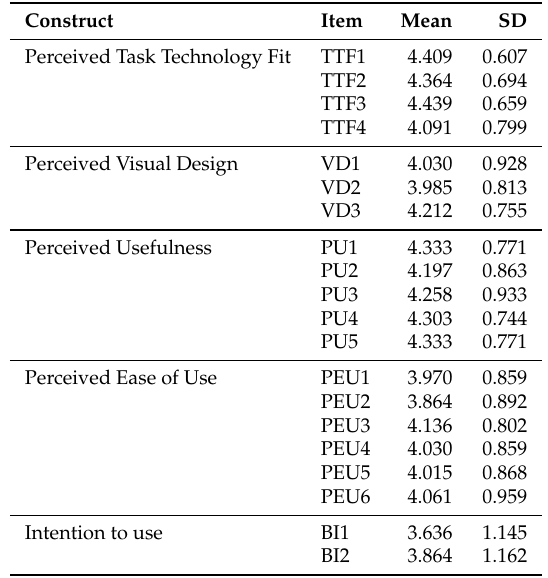
Table 3. Means and standard deviations of TAM measures (N = 66).